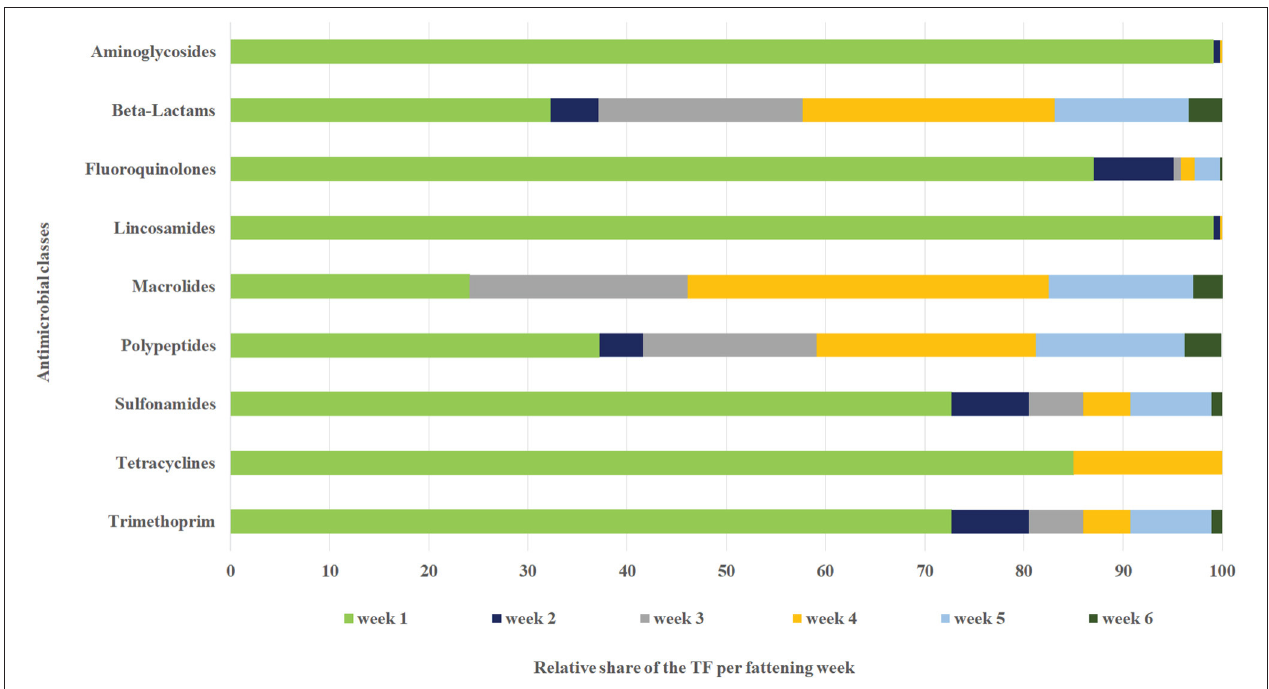
FIGURE 3 | Relative TF per antimicrobial class and fattening